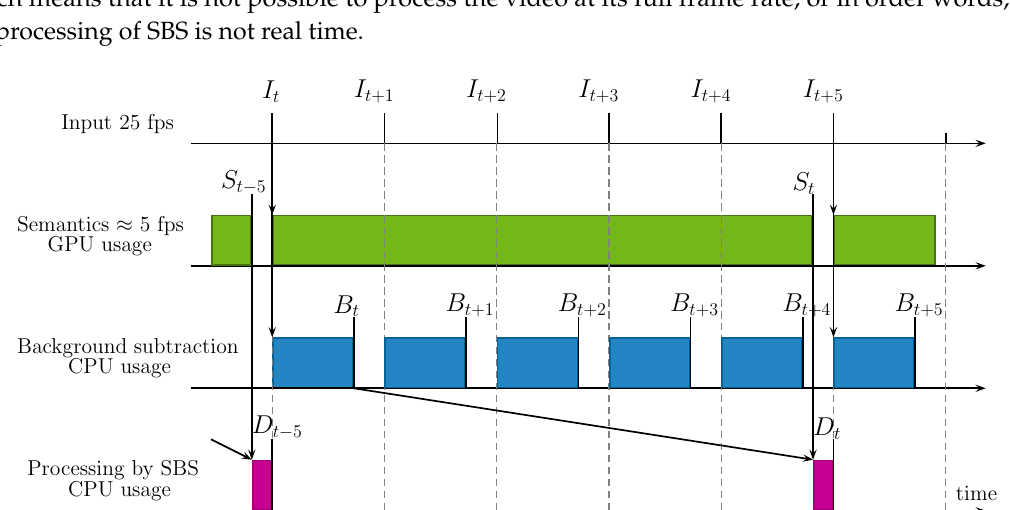
Figure 1. Timing diagram of a naive real-time implementation of the semantic background subtraction (SBS) method when the frame rate of semantics is too slow to handle all the frames in real time. From top to bottom, the time lines represent: the input frames I t , the computation of semantics S t by the semantic segmentation algorithm (on GPU), the computation of intermediate segmentation masks B t by the background subtraction (BGS) algorithm (on CPU), and the computation of output segmentation masks D t by the SBS method (on CPU). Vertical lines indicate when an image is available and filled rectangular areas display when a GPU or CPU performs a task. Arrows show the inputs required by the different tasks. This diagram shows that even when the background subtraction algorithm is real time with respect to the input frame rate, it is the computation of semantics that dictates the output frame rate.